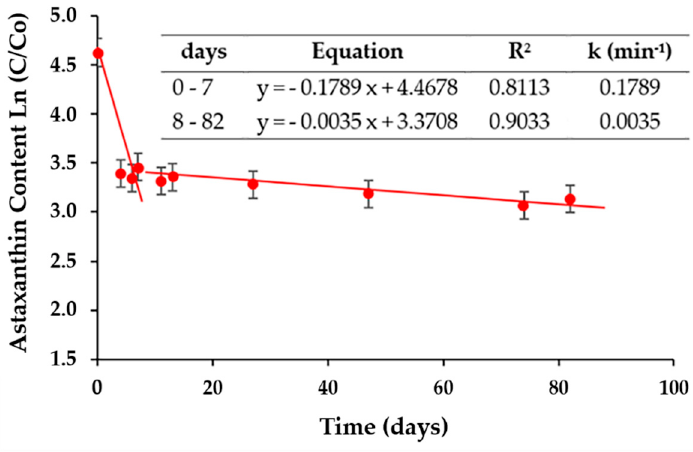
Figure 8. Degradation of astaxanthin in the isotonic beverage samples stored in darkness for three months.